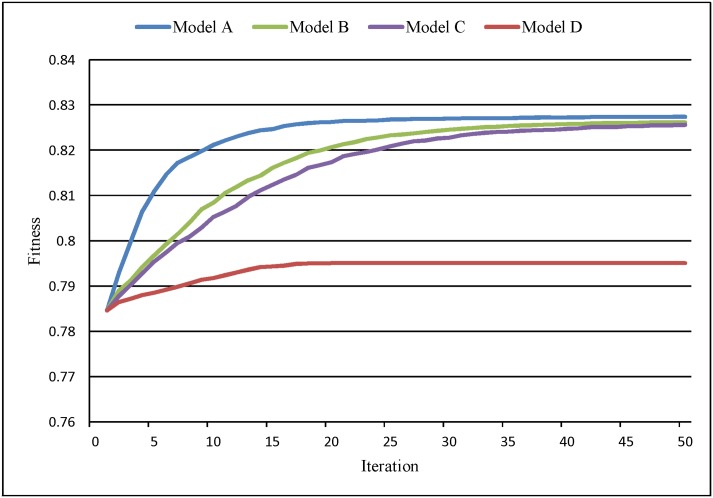
Convergence curves of Models A, B, C, D.